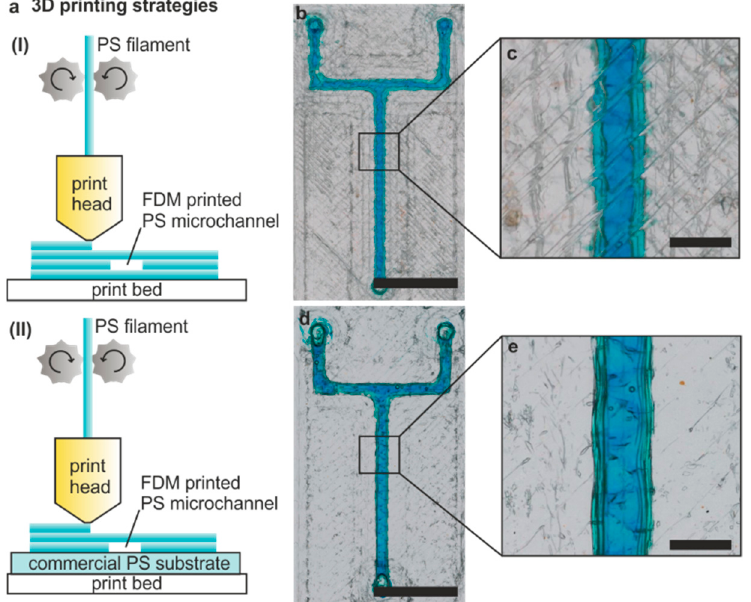
Figure 3. Three-dimensional printing strategies to improve microfluidic channel transparency. Two different strategies were used to 3D print microfluidic devices in PS: ( a ) printing directly onto the print bed (strategy I) and printing on top of a commercial PS foil (strategy II). ( b , c ) An exemplary Y-channel with a square cross-section channel of 600 µm widths and height printed using strategy I (scale bar 5 mm). The inherent layer structure reduces the transparency of the microchannels. ( d , e ) The same Y-chip as in ( b ) but printed with printing strategy II, resulting in a microfluidic channel with higher transparency in the region of interest (scale bar 600 µm).